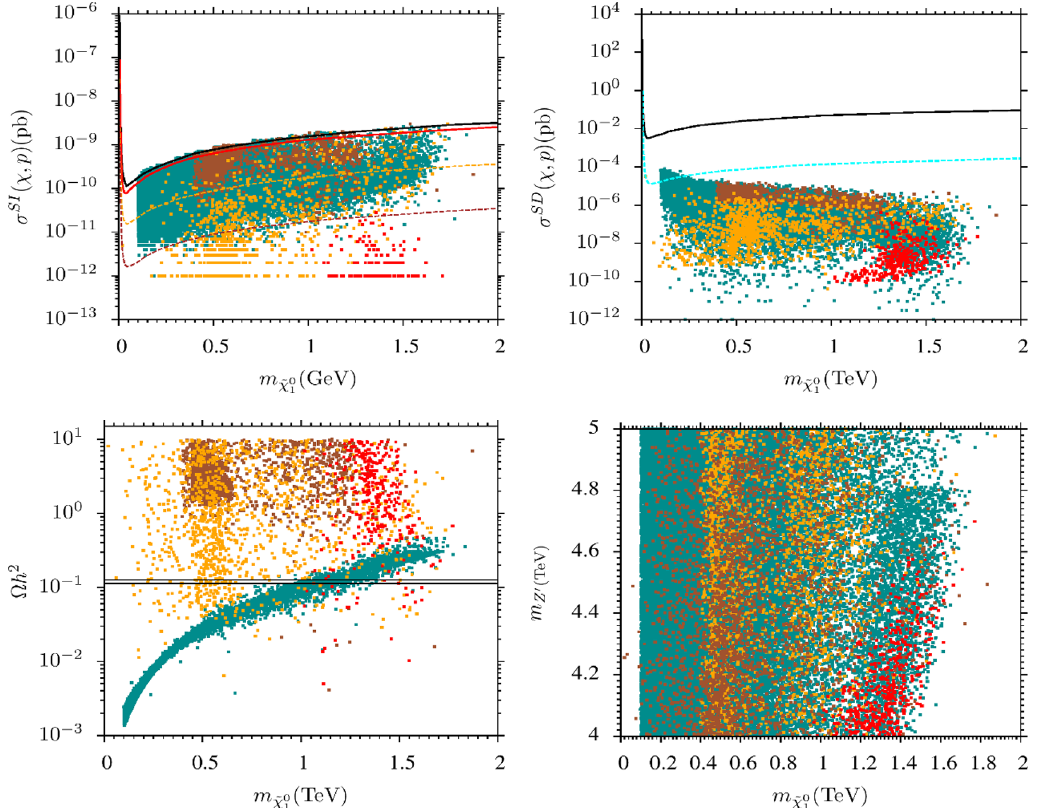
Figure 4 . Plots in the σ SI − m , σ SD − m , Ω h 2 − m and M Z 0 − m planes. Turquoise points ˜ χ 0 1 ˜ χ 0 1 ˜ χ 0 1 ˜ χ 0 1 represent higgsino-type neutralino, brown points are bino-type neutralino solutions, orange points show singlino solutions, and red points represent blino-type neutralino solutions. The horizontal lines in the top-right panel indicate the DM relic density bounds given in eq. (3.9). In the bottom-left panel, the solid black and red lines respectively represent the current LUX [67] and XENON1T [68, 69] bounds, and the dashed orange and brown lines show the projection of future limits [70] of XENON1T with 2 t · y exposure and XENONnT with 20 t · y exposure, respectively. In the bottom- right plot, the black solid line is the current LUX bound [71] and the cyan dashed line